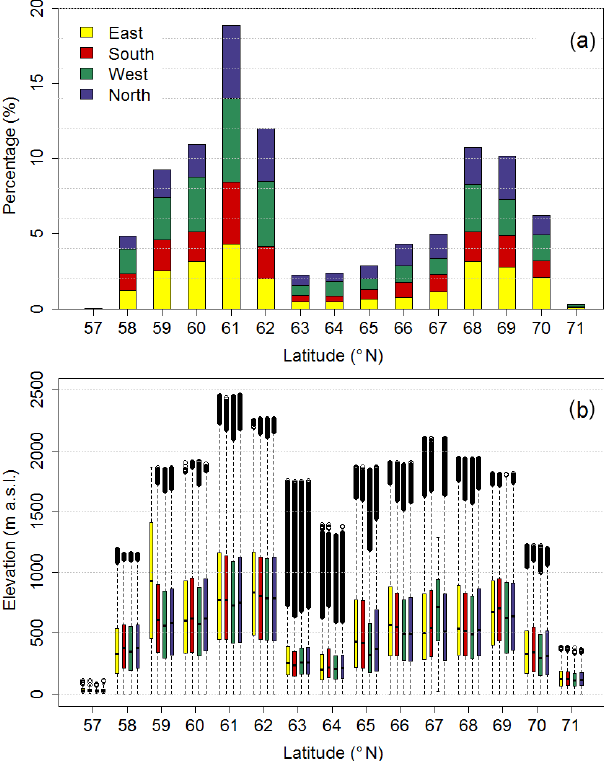
Figure 6. (a) Measured mean annual rock surface temperature (MARST) versus interpolated MAAT at the MARST measurement points. (b) Surface offset (i.e. MARST measured – MAAT interpo- lated) versus calculated potential incoming solar radiation (PISR) at measurement points. The multiple MARST points for the same PISR values result from multiple years of RST records at the same logger and for which the PISR value remains identical.